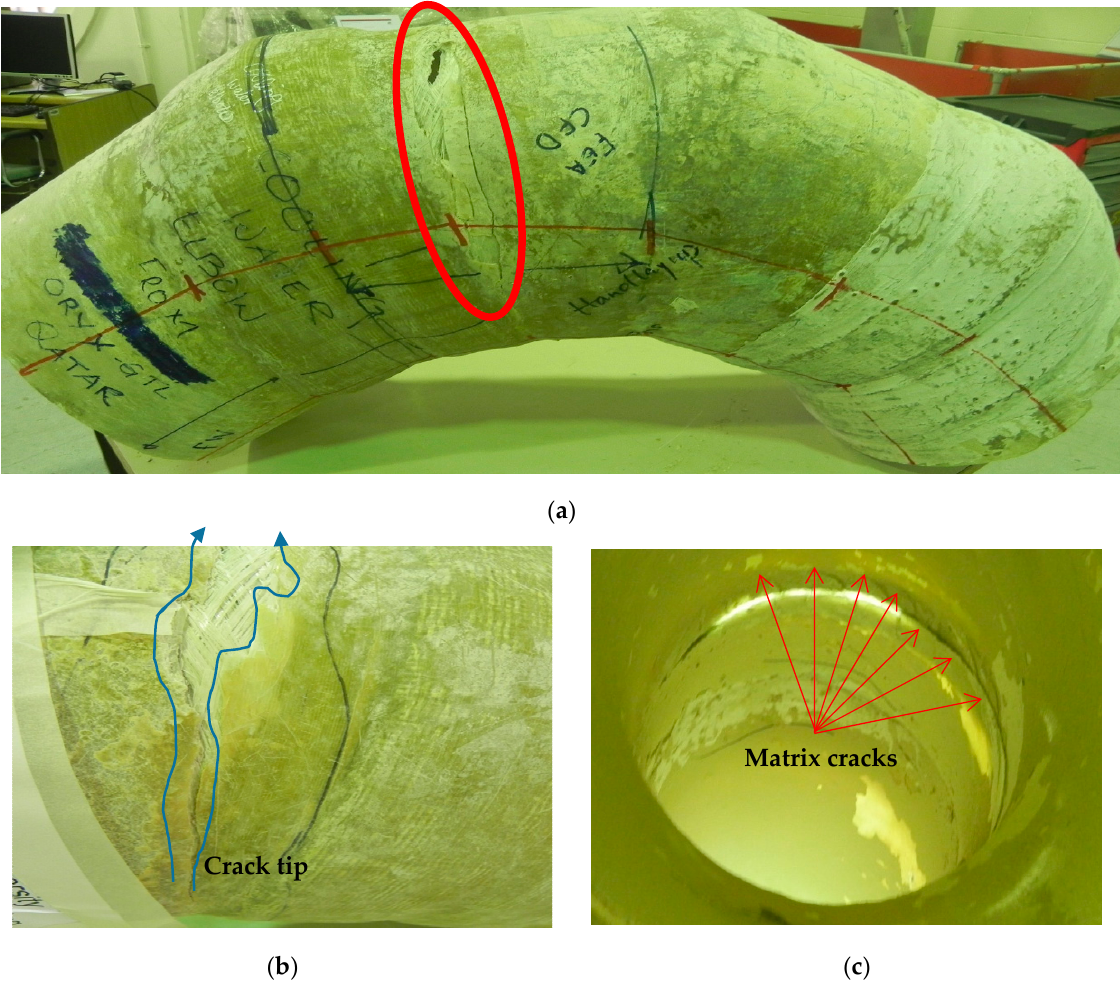
Figure 1. ( a ) Failed elbow; ( b ) a radial crack showing matrix cracking and fiber breakage; ( c ) transverse matrix cracks.